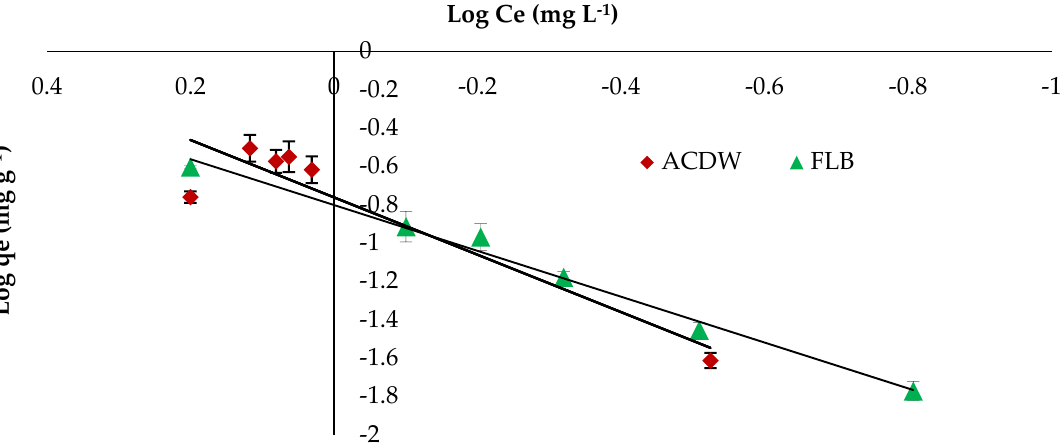
the Ln C e Halsey adsorption isotherms are shown in Figure 11. The parameters obtained for the Halsey isotherm were fitted with ACDB and LFB adsorbents, with high regression correlation coefficients ranging between 0.856 and 0.989. The Halsey isotherm parameters of K and n are presented in Table